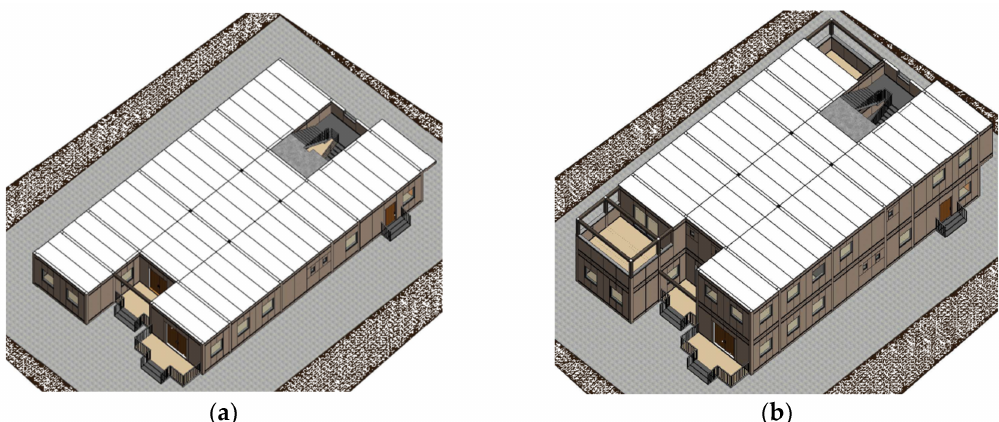
Figure 6. Study of the SIPs as modular movable wall, floor and roof panels supported within the steel framing of 20 cm × 20 cm tubular sections post and beam: ( a ) Ground Floor, ( b ) 1st Floor.